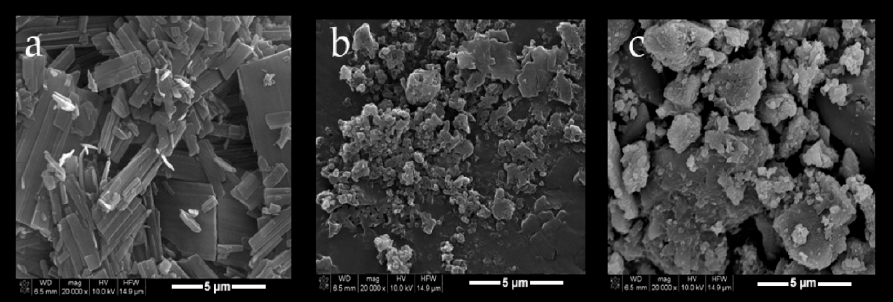
Figure 3. Scanning electron microscopy (SEM) photomicrographs of PCX ( a ); PCX:6OCapro β CD inclusion complex ( b ) and PCX:PC β CDC6 inclusion complex ( c ). (Adapted with permission from Ref [30]).